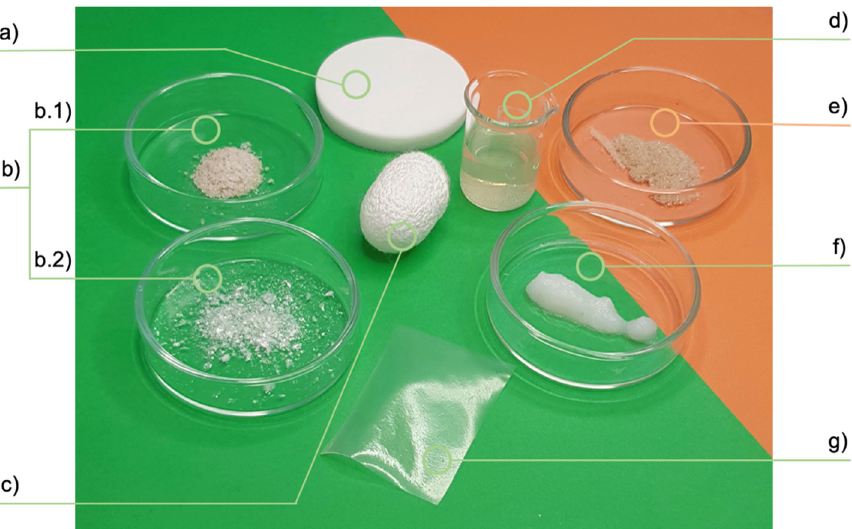
Figure 2. Examples of silk-protein-based products. ( a ) fibroin scaffold; ( b ) fibroin powders, both soluble ( b . 1 ) and insoluble ( b . 2 ); ( c ) silk cocoon; ( d ) fibroin solution; ( e ) sericin powder; ( f ) fibroin gel; ( g ) fibroin membrane.